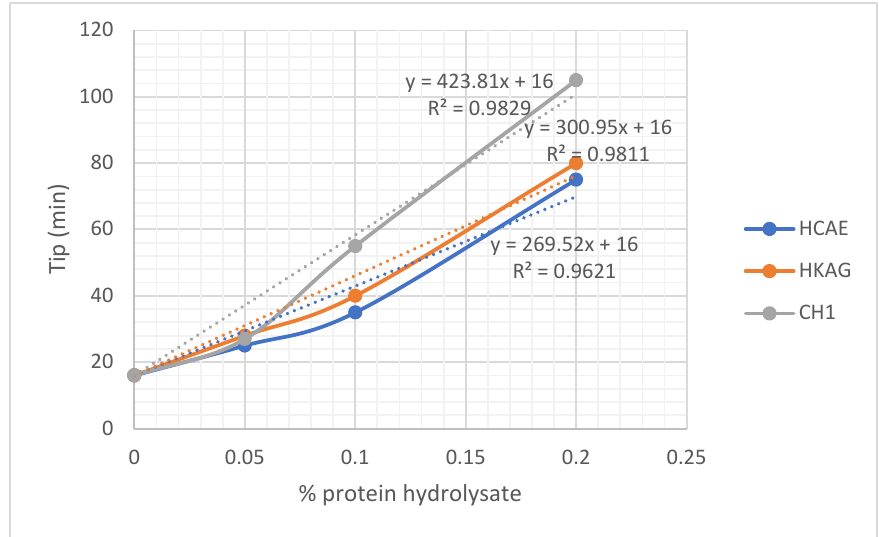
Figure 7. Variation of initial time for plaster setting as a function of protein hydrolysate concentration. Dotted lines represent a linear estimation of initial setting time as a function of hydrolysates dosage w/w. For the case when no hydrolysates were used, initial and final setting time is for gypsum plaster alone (16 min).